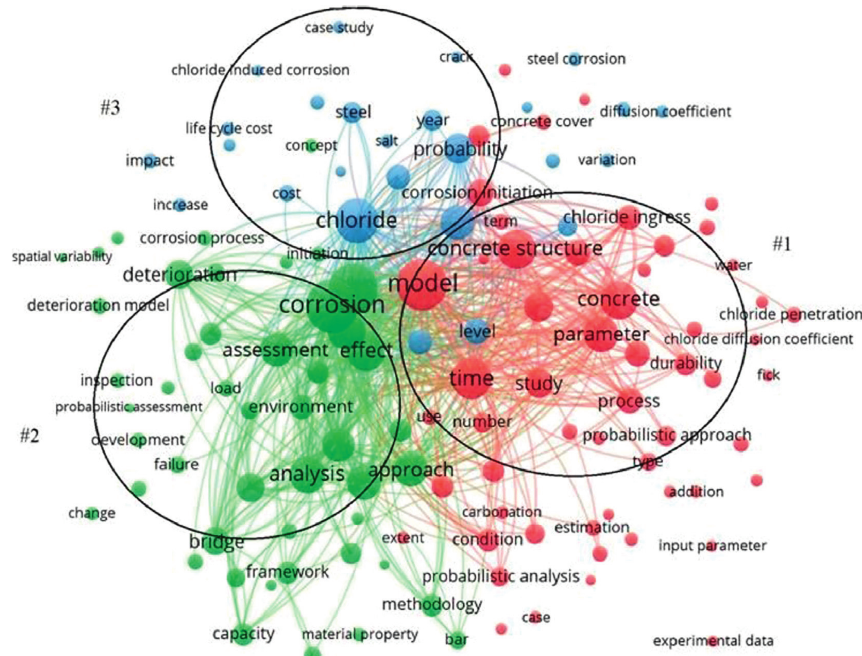
Figure 8: Keywords cooccurring network analysis with at least ten occurrences.